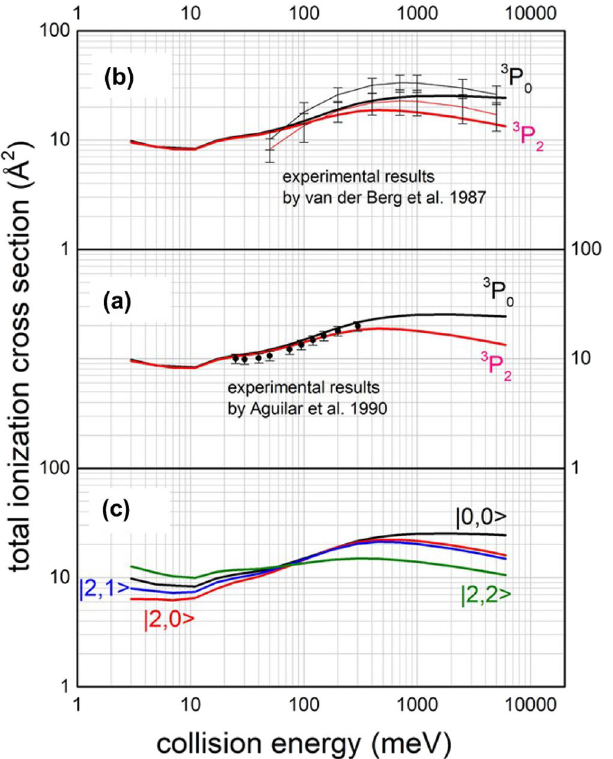
Figure 4. Total ionization cross sections for Ne * ( 3 P 2,0 )-N 2 as a function of the collision energy. ( a ) The full circles are results from the Perugia laboratory 29 . Marked red and black lines indicate the calculations of the present study carried out within the semiclassical approach 6,7 and according to Eq. (3). ( b ) thin-pink and thin- black lines represent polynomial functions interpolating data measured in the Eindhoven laboratory 18 . Vertical error bars are representative of the uncertainties on the absolute scale of cross sections. Full lines are the same of ( a ) panel. ( c ) the contribution from each entrance channel leading to the formation of N 2 + in its ground 2 Σ g + electronic